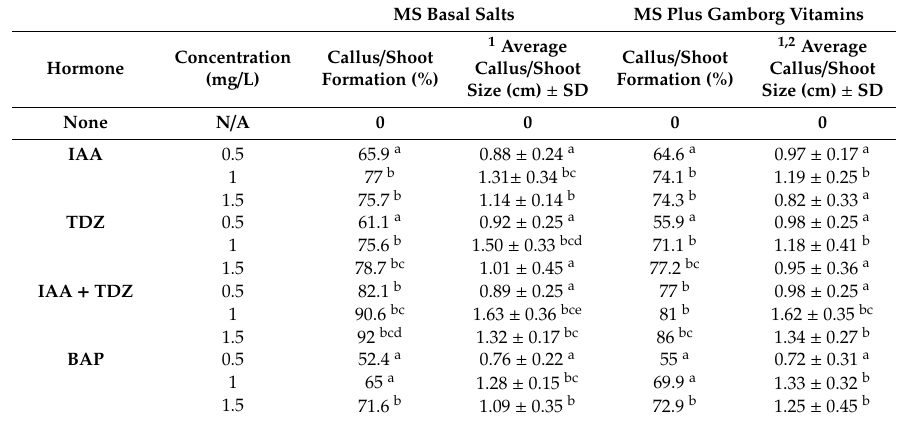
Table 1. Effects of medium and hormone types on the efficacy of callus / shoot induction in Ornithogalum